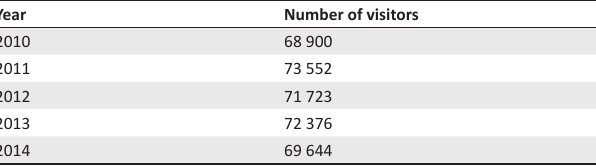
TABLE 1: The number of visitors at the NAMPO Harvest Day